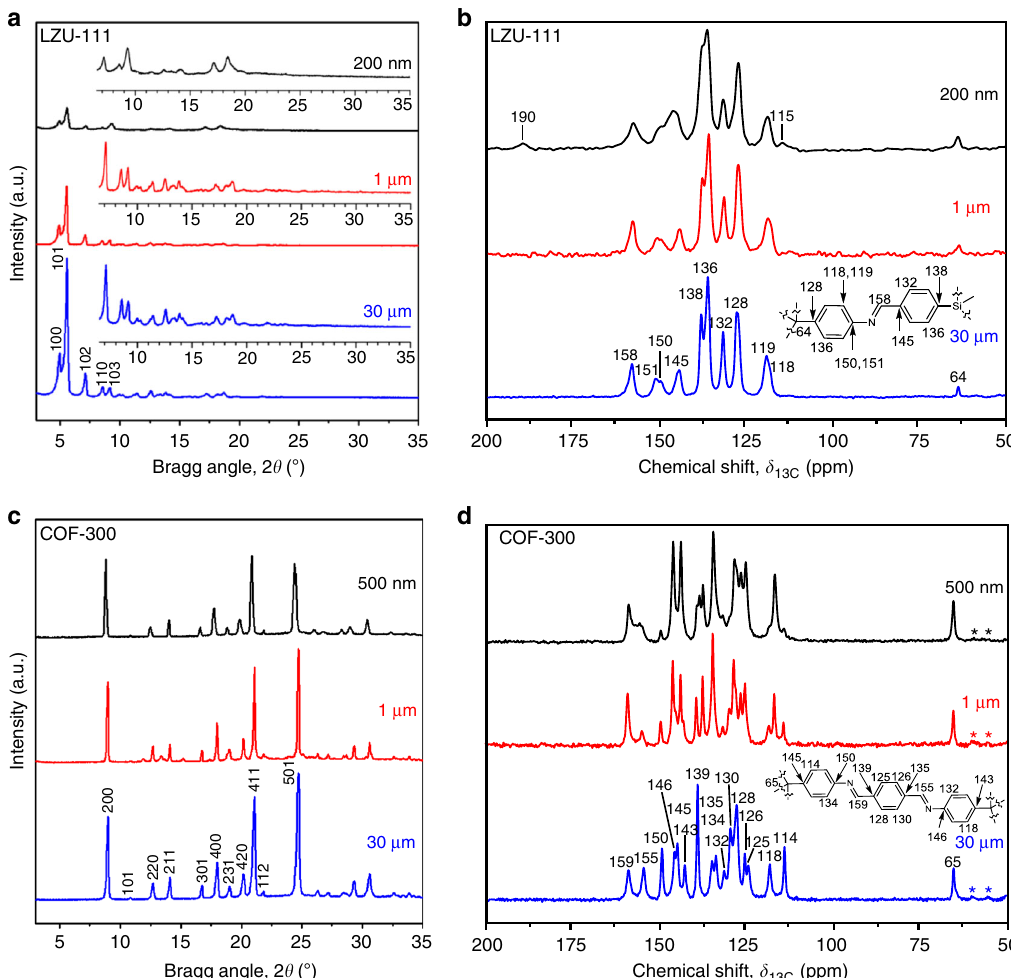
Fig. 3 PXRD and SSNMR for different-sized LZU-111 and COF-300 (200nm-sized LZU-111 and 500 nm-sized COF-300, black; 1 μ m-sized LZU-111 and COF-300, red; 30 μ m-sized LZU-111 and COF-300, blue). a PXRD patterns of different-sized LZU-111. Inset: magni fi ed patterns of 2 θ = 6 – 35°. b 13 C CP/ MAS spectra of different-sized LZU-111. The assignment of 13 C chemical shifts are indicated in the chemical structure. c PXRD patterns of different-sized COF-300. d 13 C CP/MAS spectra of different-sized COF-300. Asterisks denote spinning sidebands. The assignment of 13 C chemical shifts are indicated in the chemical